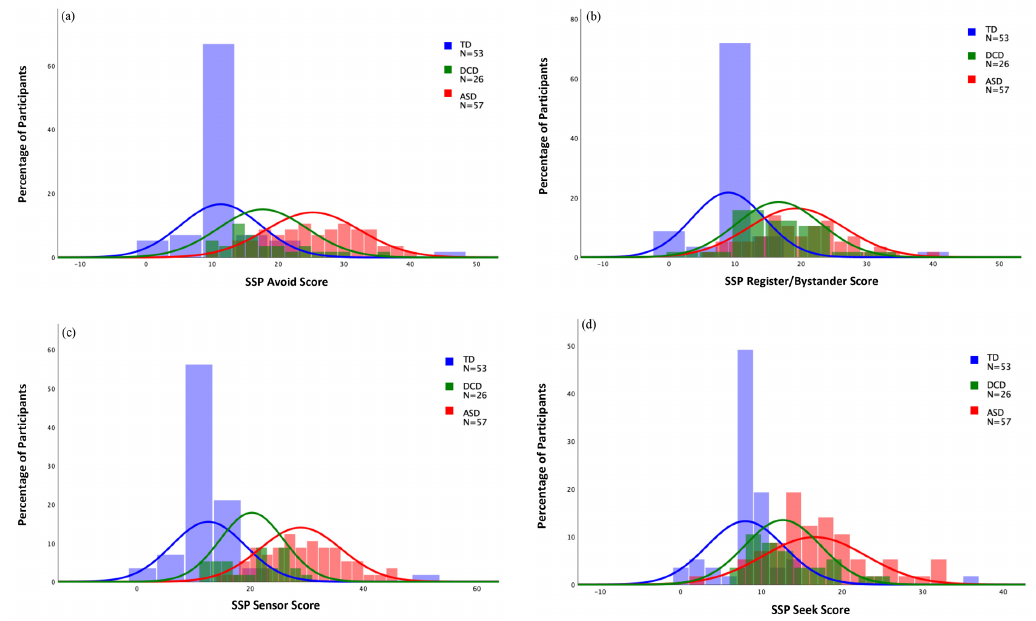
Figure 2. Histograms for SSP-2 sensory response patterns. ( a ) Avoider; ( b ) bystander; ( c ) sensor; ( d )